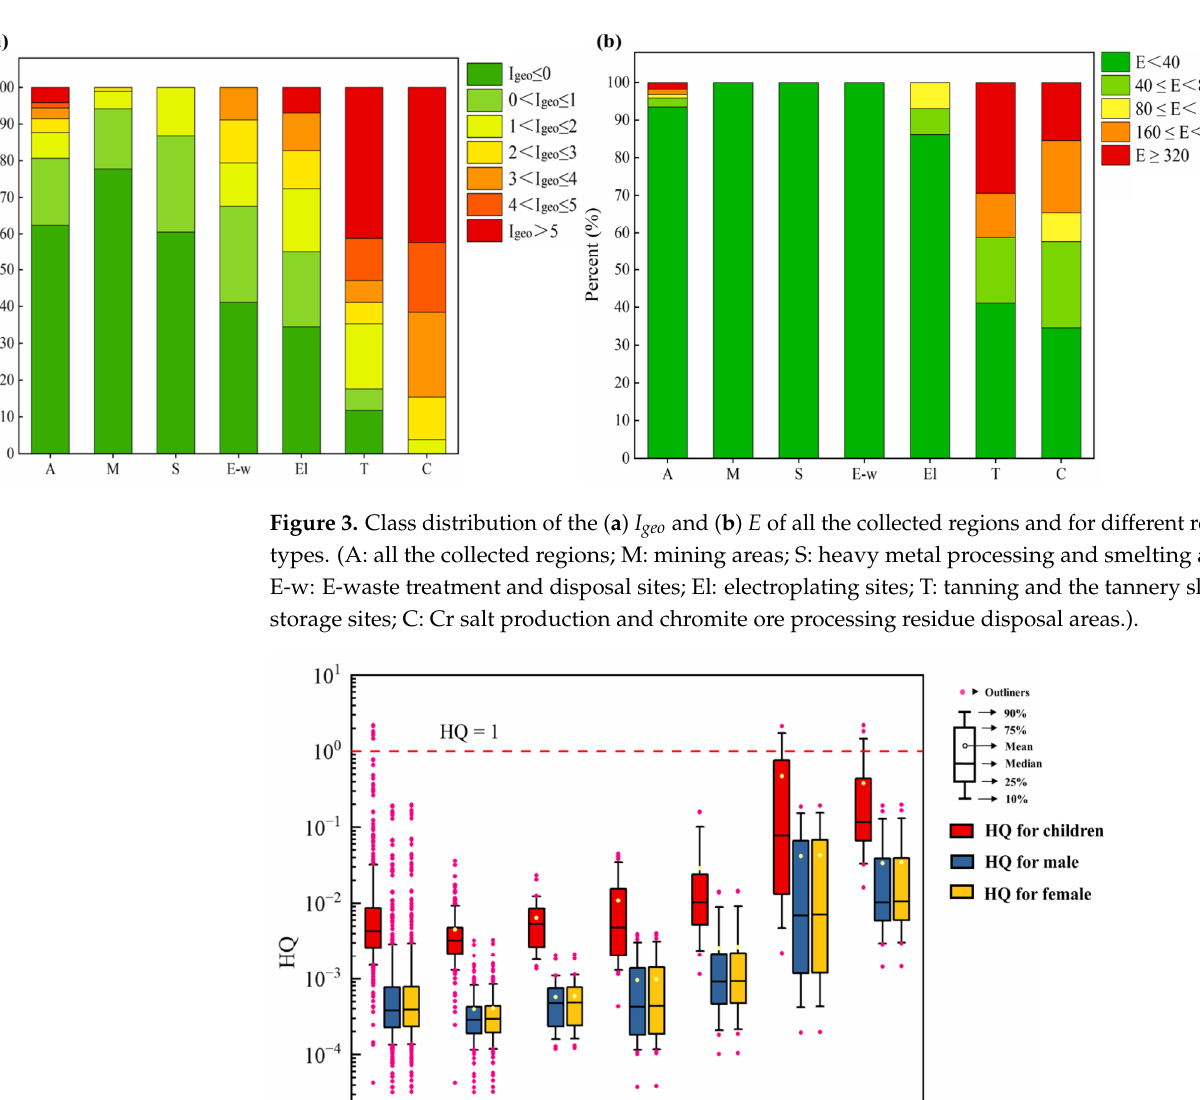
Figure 3. Class distribution of the ( a ) I geo and ( b ) E of all the collected regions and for different region types. (A: all the collected regions; M: mining areas; S: heavy metal processing and smelting areas; E-w: E-waste treatment and disposal sites; El: electroplating sites; T: tanning and the tannery sludge storage sites; C: Cr salt production and chromite ore processing residue disposal areas.).